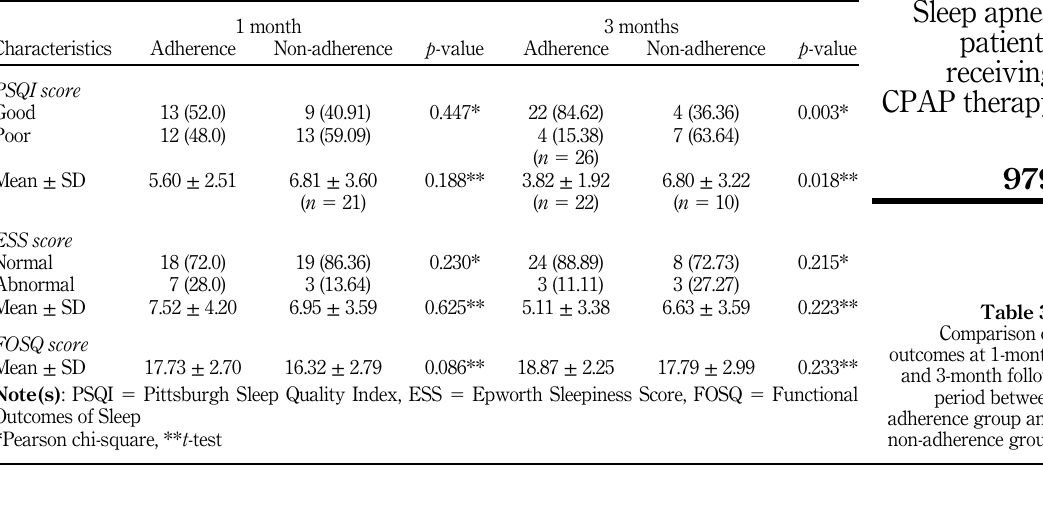
Table 4. Effectiveness of